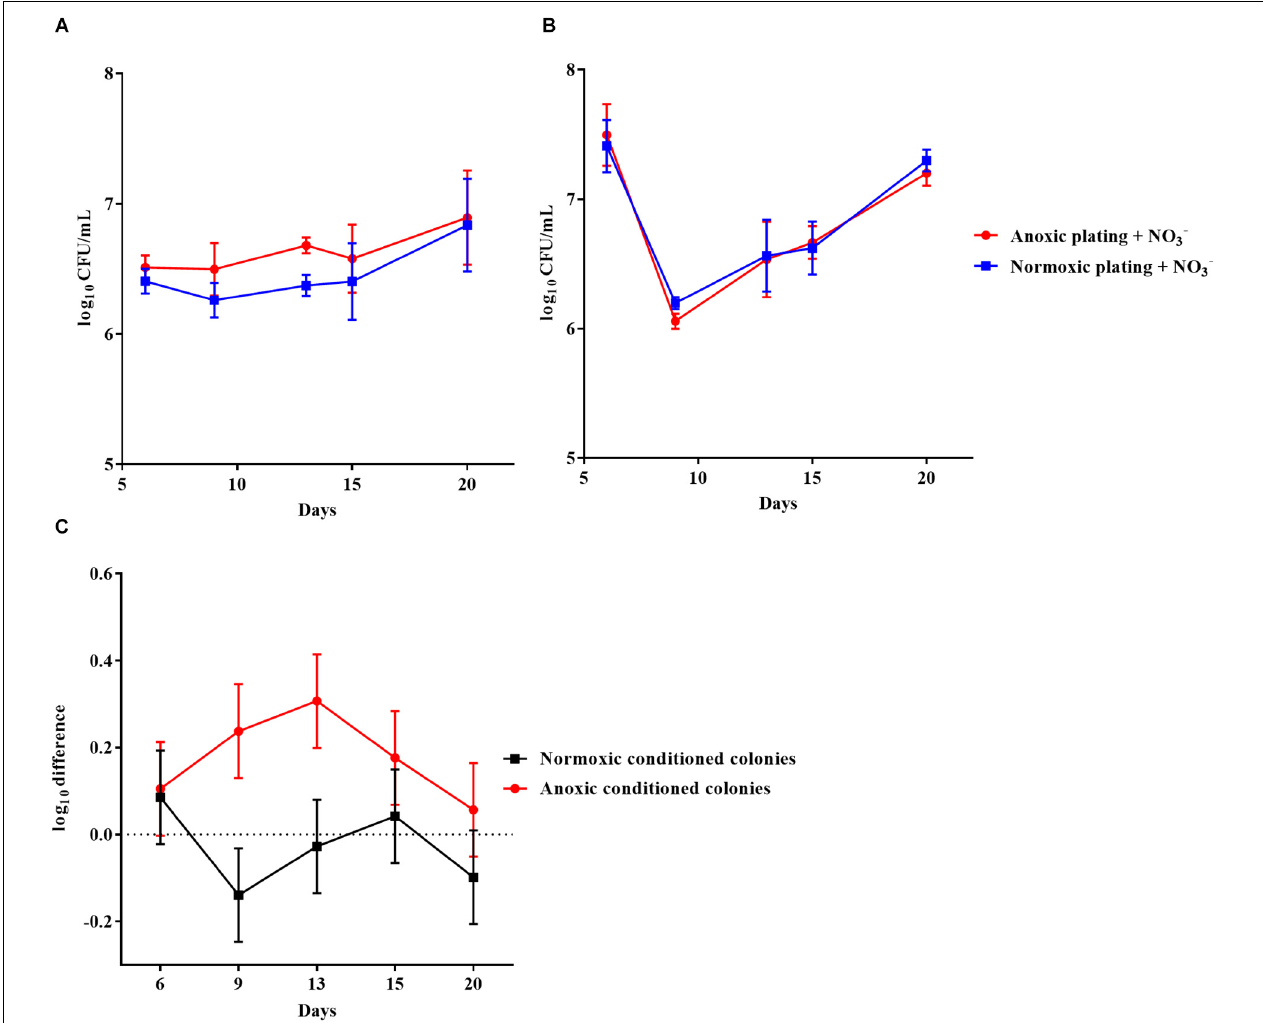
FIGURE 5 | An oxygen intolerant subpopulation of Pseudomonas aeruginosa (PAO1) was generated in colonies. Normoxic and anoxic colony forming units per milliliter (CFU/mL) of PAO1 over 20 days from anoxically (A) and normoxically (B) conditioned colonies. Symbols with error bars indicate the mean ± SEM ( n = 3). + NO 3 - refers to the addition of 10 mM KNO 3 to LB agar plates. The log difference (C) represents the difference in mean log CFU/mL between plating methods from the normoxically and anoxically conditioned colonies, respectively. The log difference was significantly higher ( p < 0.0001, linear regression) in the anoxically conditioned colonies than the normoxically conditioned. Symbols with error bars indicate the mean + confidence intervals.